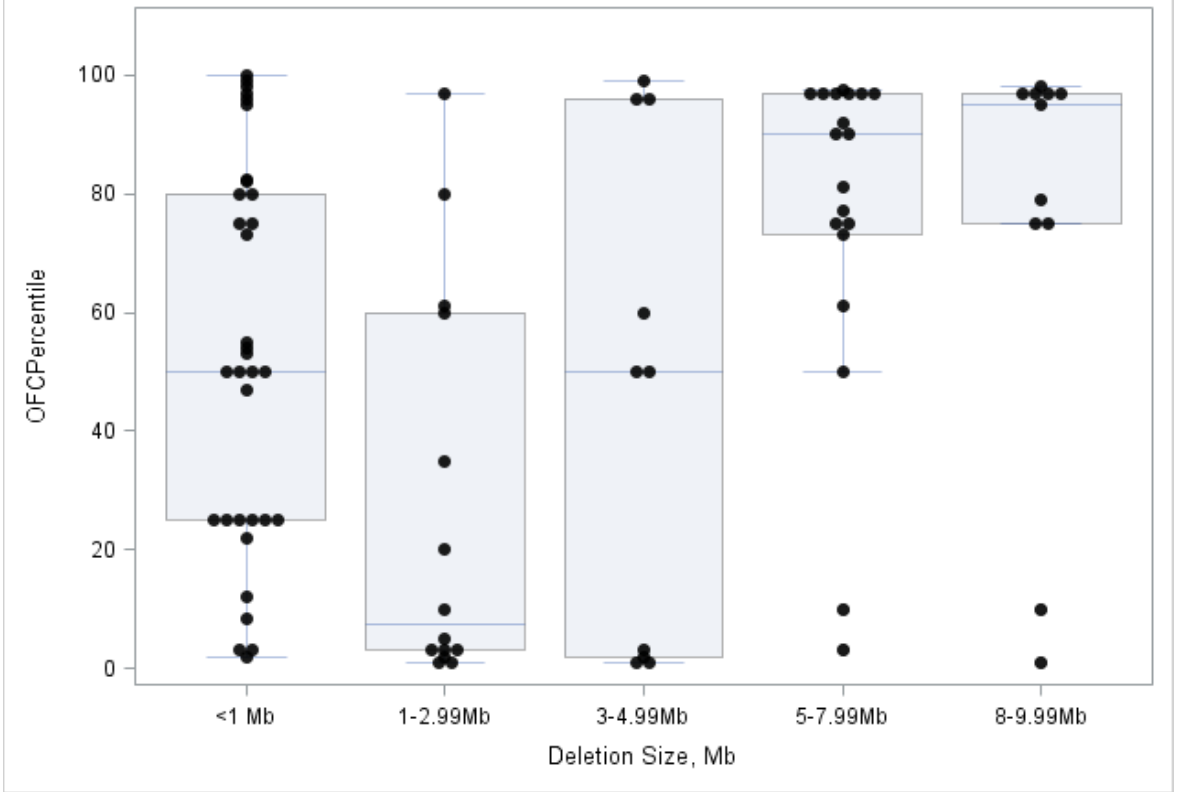
Figure 3. Distribution of OFC percentile by chromosome 22q13 deletion size for 87 individuals with partially or fully deleted SHANK3 .